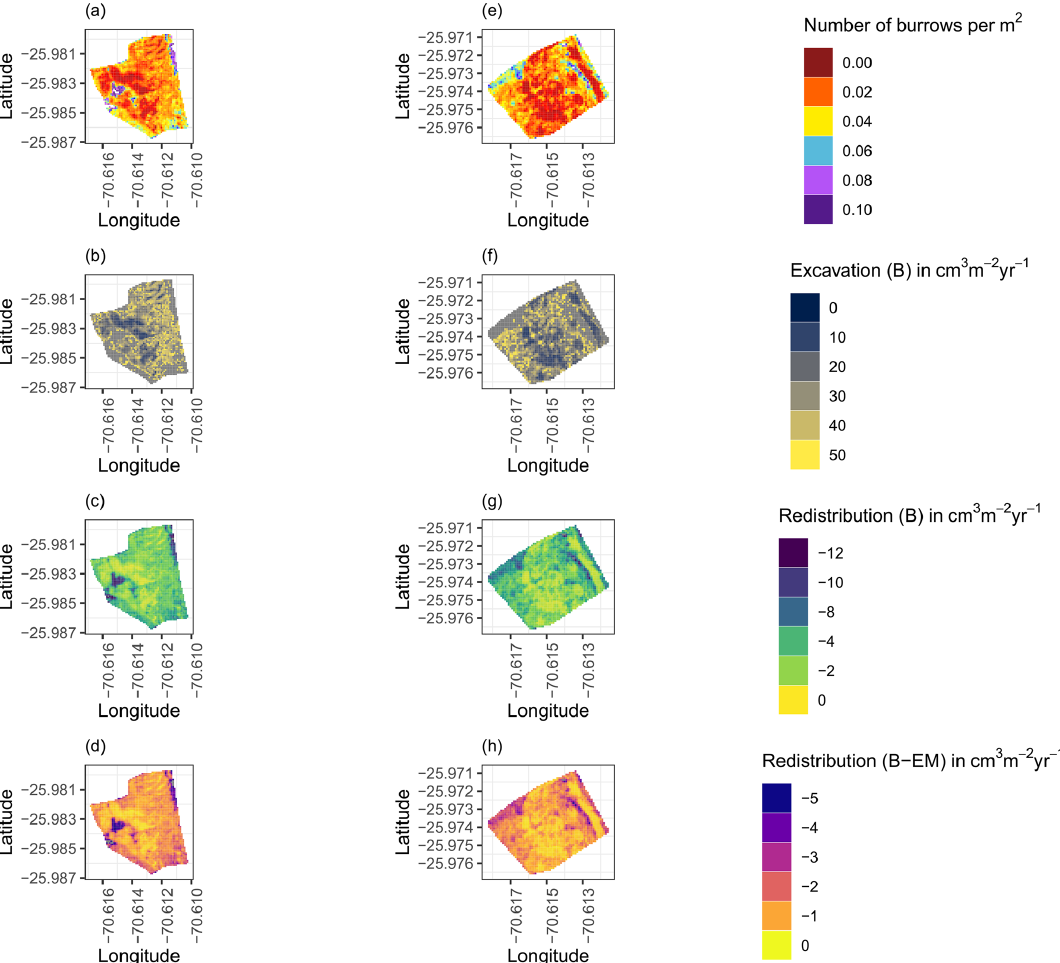
Figure A9. Hillslope-wide volume of redistributed sediment for a time period of 1 year at PdA for the (a–d) north-facing hillslope and (e–h) south-facing hillslope. (a, e) Density of burrows as estimated by Grigusova et al. (2021). (b, f) Volume of the sediment excavated by the animals. (c, g) Volume of the sediment redistributed during rainfall events within burrows. (d, h) Volume of additionally redistributed sediment during rainfall events due to the presence of the burrows. The values were calculated per burrow as stated in Sect. 3.7 by subtracting the sediment volume redistributed within burrow from the sediment volume redistributed within burrow embedding area and then upscaled. B stands for burrow, and EM stands for burrow-embedded